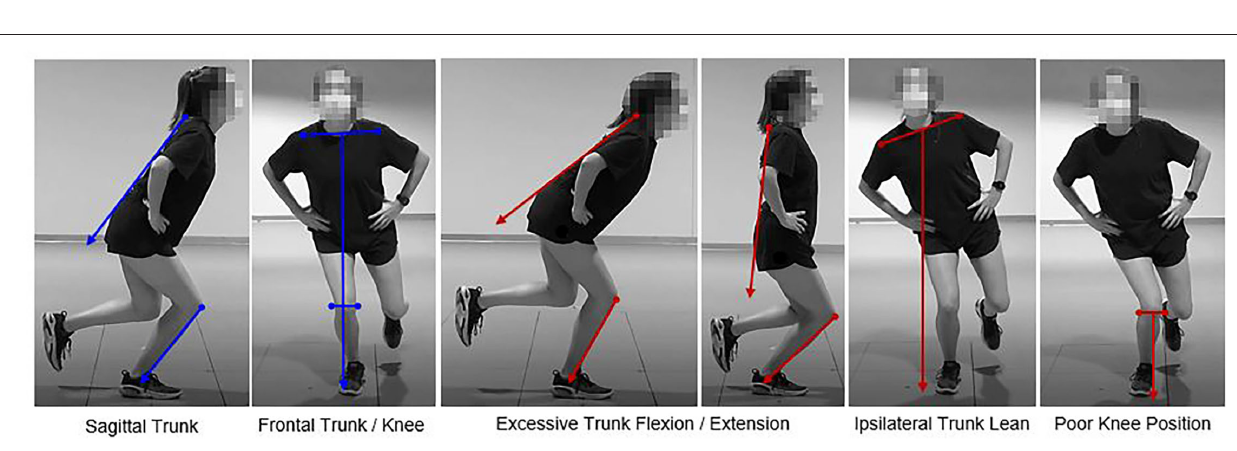
the third attempt, their 2D data were not scored and removed from the